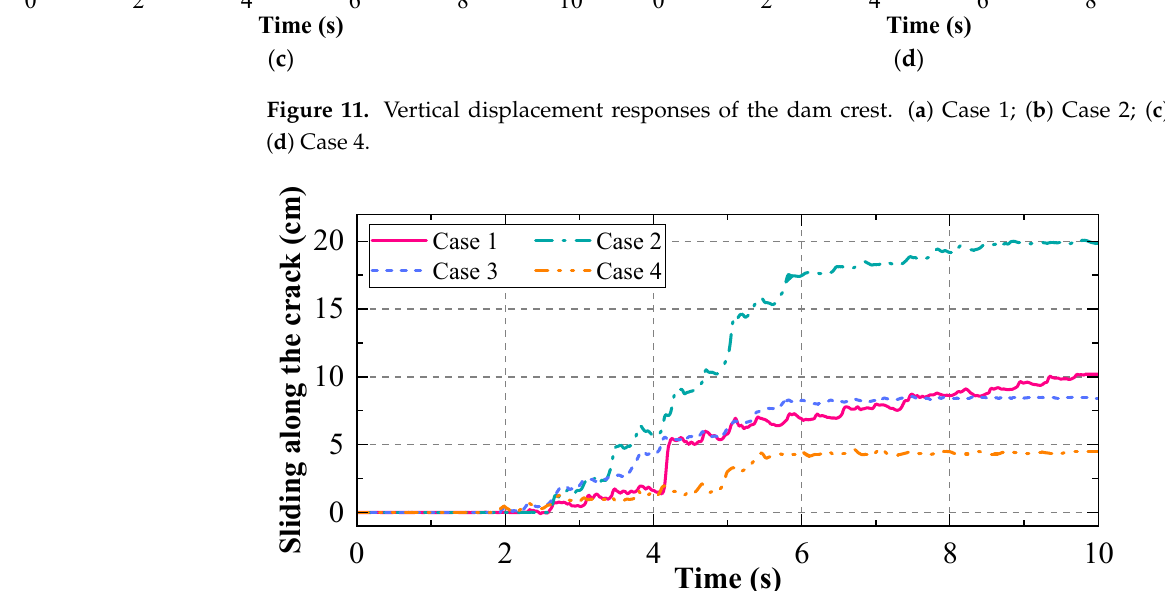
Figure 12. Sliding displacement histories of four cases.